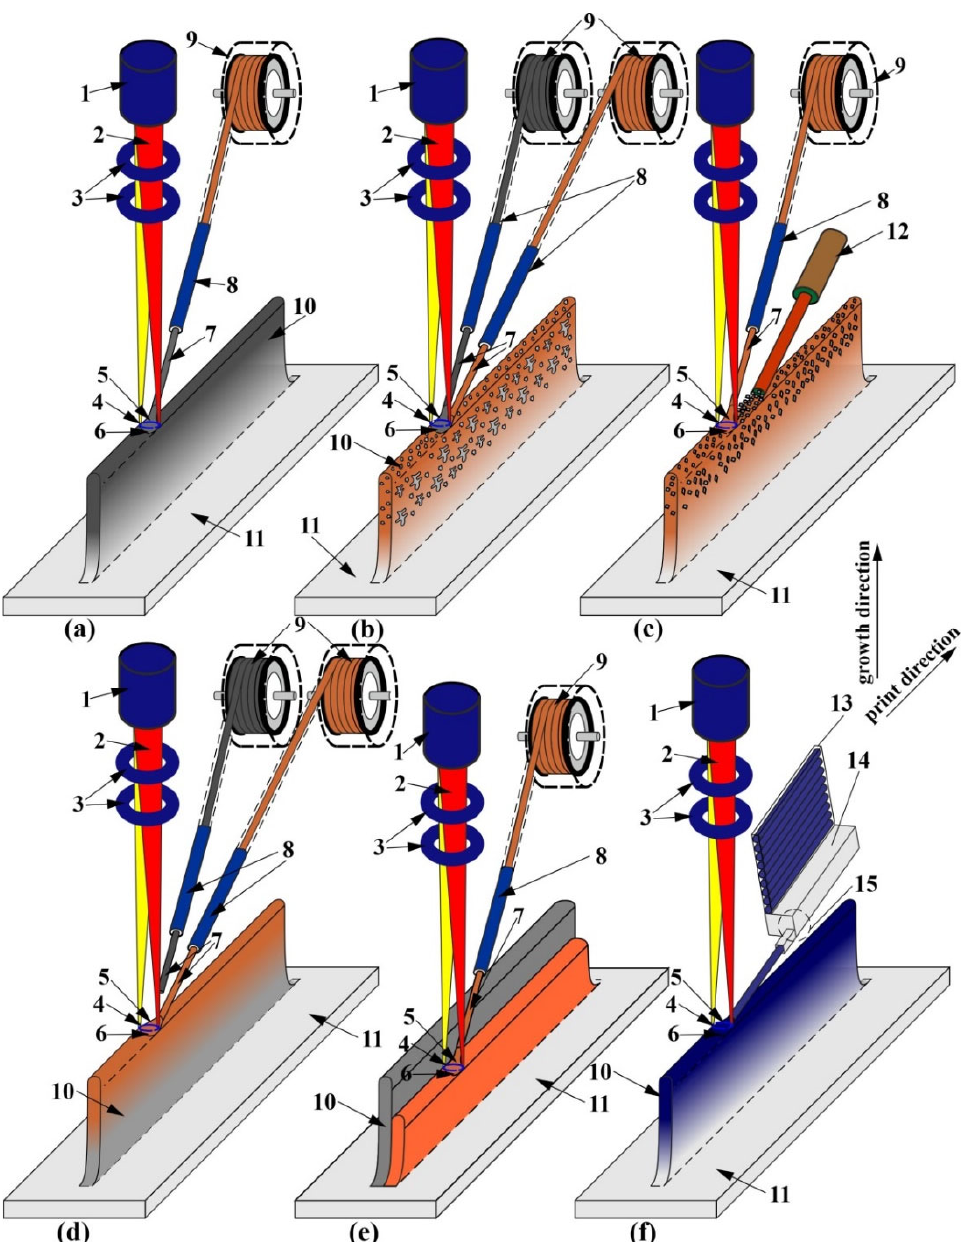
Figure 1. ( a ) Schematic of wire-feed additive electron beam production of samples with monometallic, ( b ) polymetallic composite structure when printing with two filaments, ( c ) combined wire-powder printing, ( d ) formation of two-component bimetallic elements when printing one alloy on top of the other, ( e ) two ‐ row sample production, ( f ) printing using rod feeder.